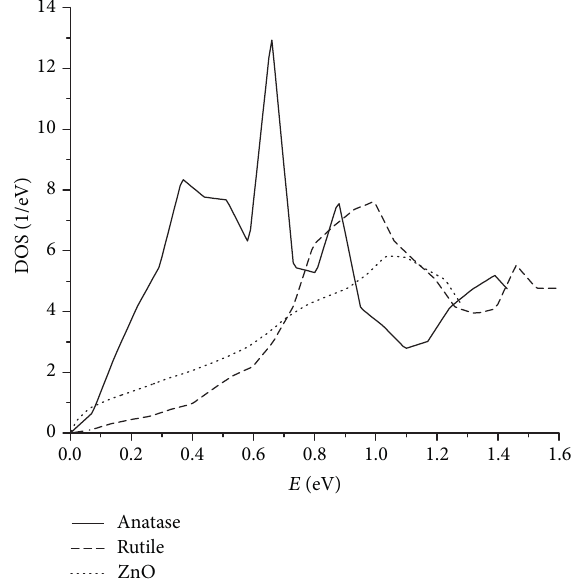
Figure 7: The total density of states near the top of the valence band versus the excess energy. The solid line is for anatase, the dashed line is for rutile, and the dotted line is for zinc